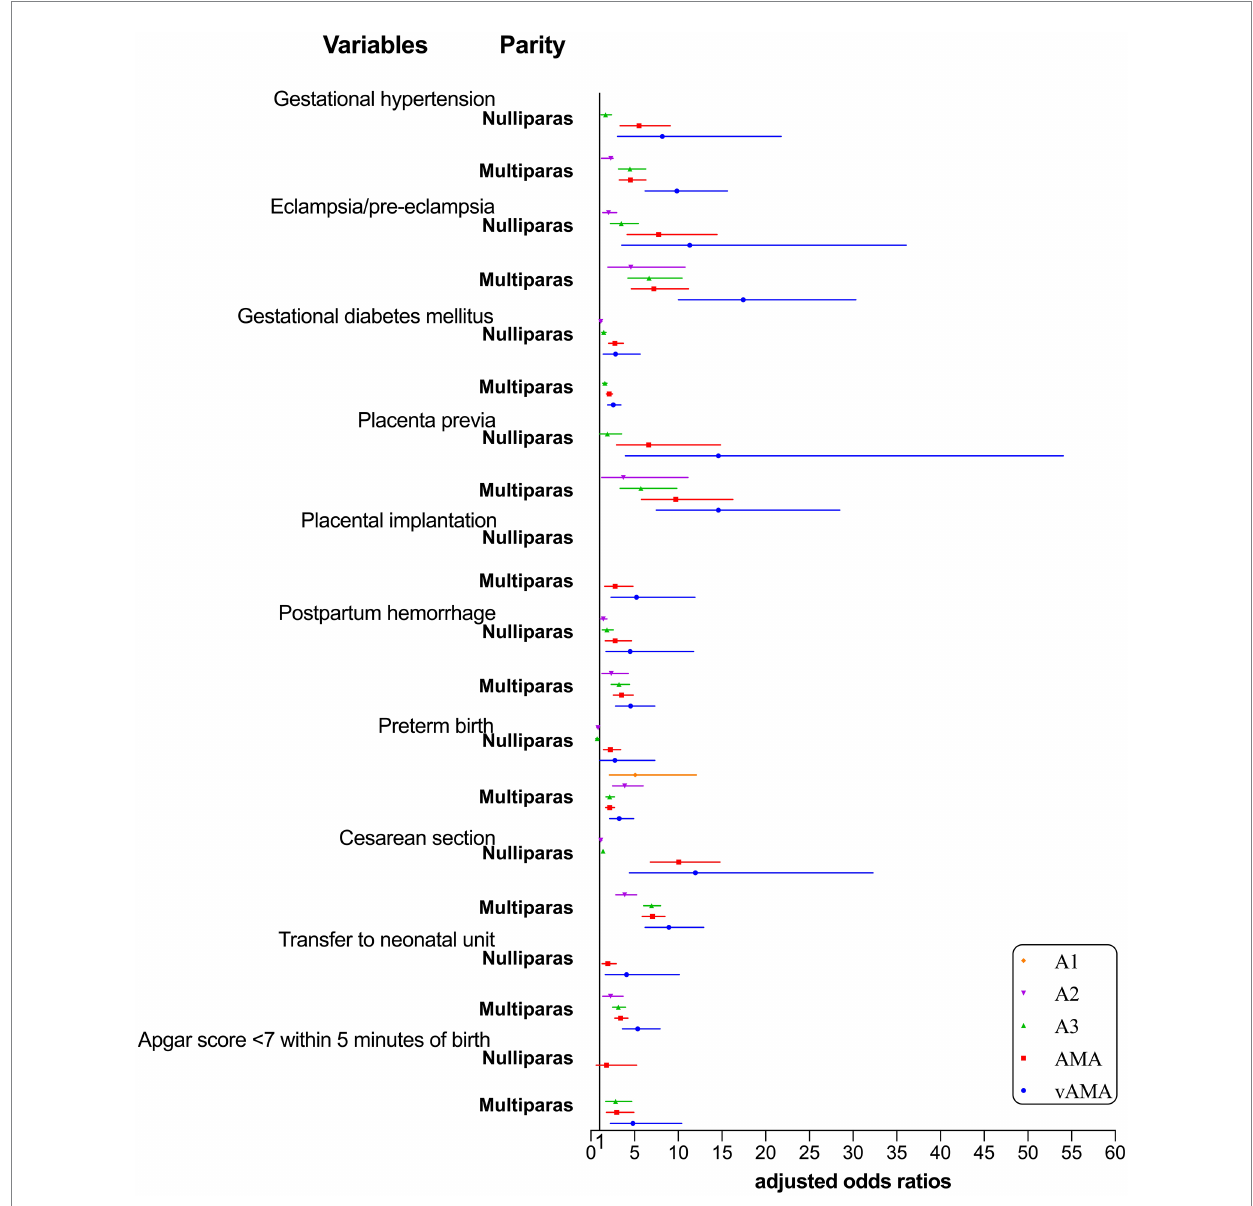
FIGURE 3 Forest plot for risk of adverse pregnancy outcomes and neonatal outcomes by group with different ages and